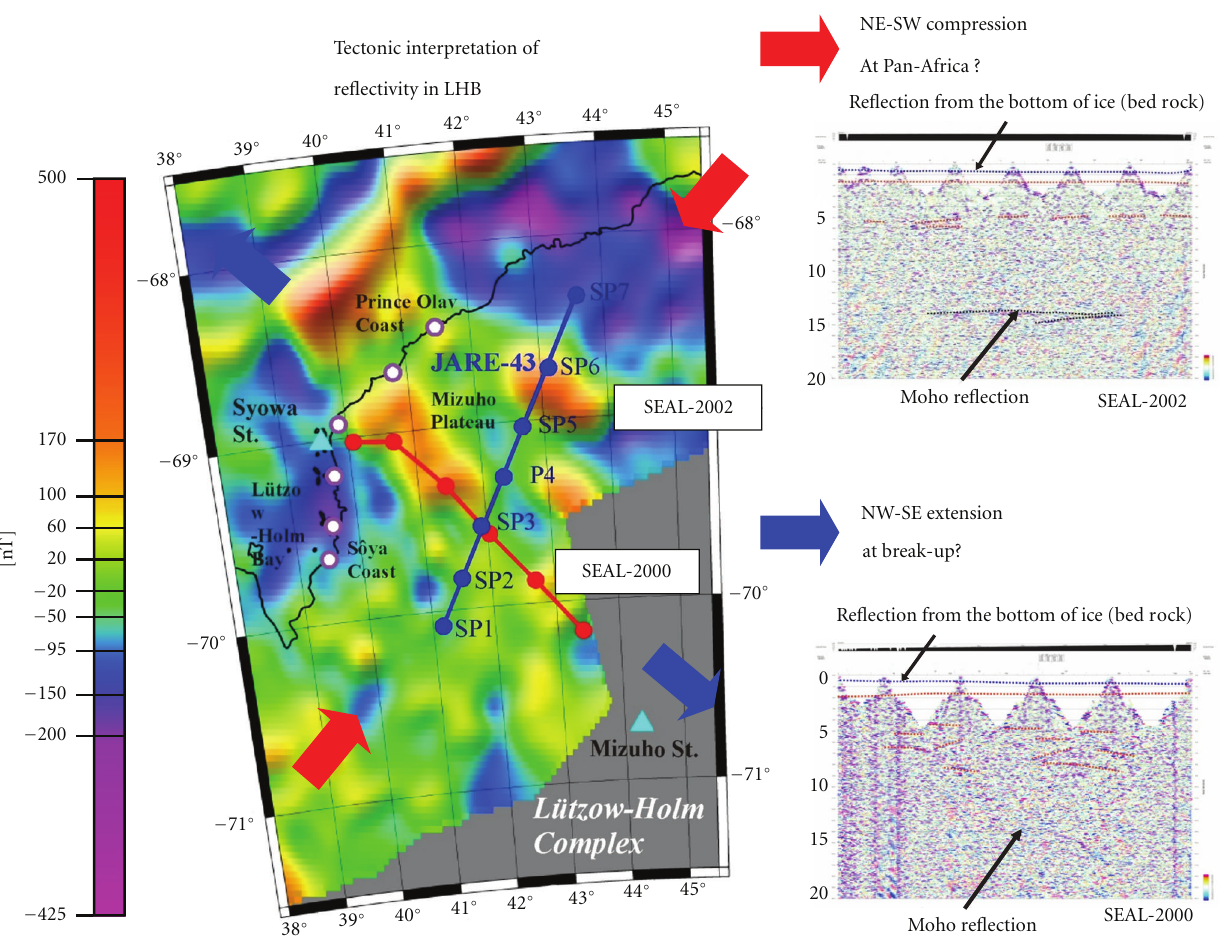
Figure 13: Aeromagnetic anomalies (by Golynsky et al., 1996 [18]) around LHB with GARNET stations and DSS profiles (modified after Kanao et al., 2010 [17]). Tectonic interpretation is illustrated with associated interpretations of reflection cross sections by DSS.